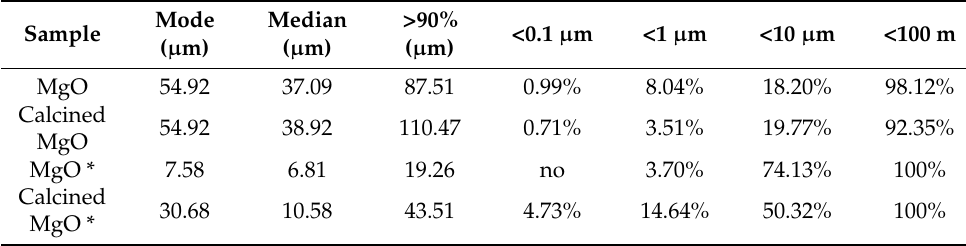
Figure 4. Size distribution of MgO ( a , b ) and calcined MgO ( c , d ) (dashed curve—size distribution after the effects of ultrasound on powders). Table 3. The results of granulometric analysis of